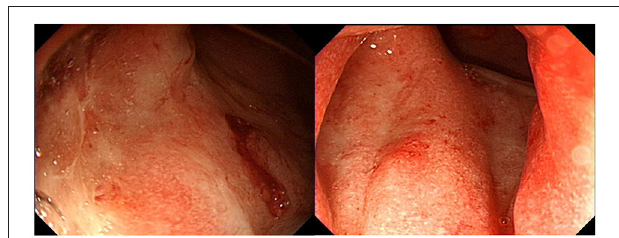
FIGURE 1 | Sigmoidoscopy demonstrating superficial ulcers and erosion confined to the rectum.